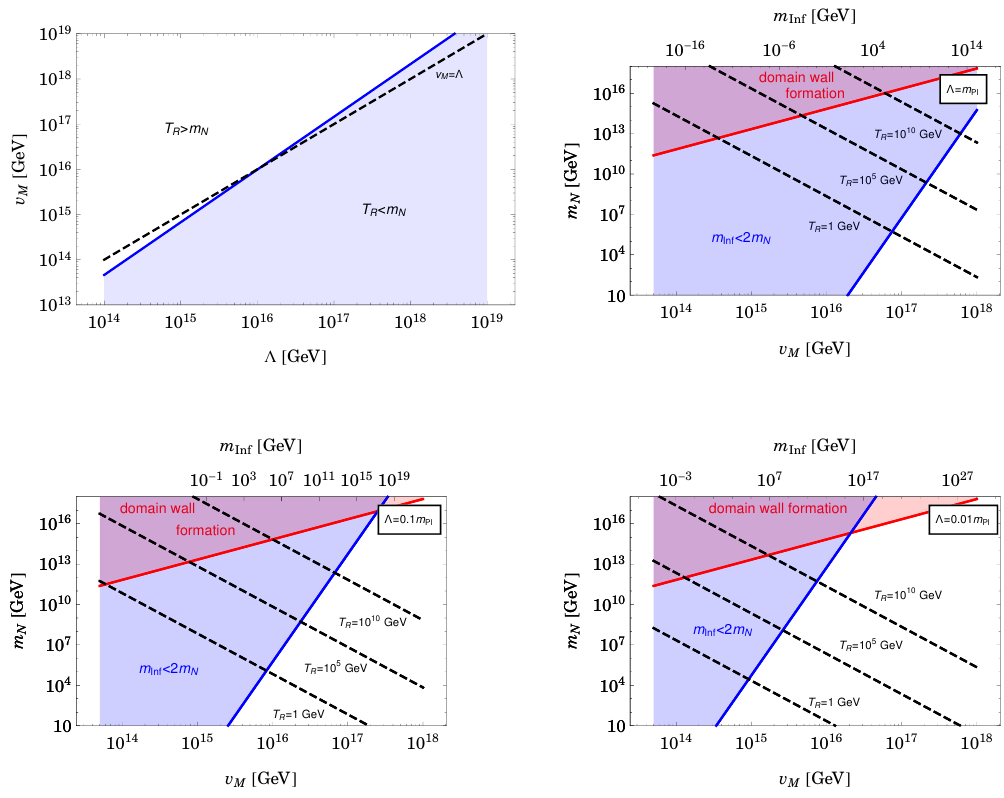
Figure 3 . The allowed regions (in white) of the parameter space for n = 9. Upper left: this plot shows the values of v M as a function of (cid:3) such that T R > m N , i.e. the right-handed neutrinos thermalize. The dashed black line indicates v M = (cid:3). Upper right: the allowed parameter space (in white) for n = 9 and (cid:3) = m Pl . The blue shaded area is excluded due to the kinematic condition m Inf > 2 m N , and the red shaded area is excluded due to domain wall formation. The three dashed lines are the lines of constant reheat temperature 1 GeV, 10 5 GeV and 10 10 GeV, respectively. Lower left and lower right: the same plots for (cid:3) = 0 : 1 m Pl and (cid:3) = 0 : 01 m Pl ,